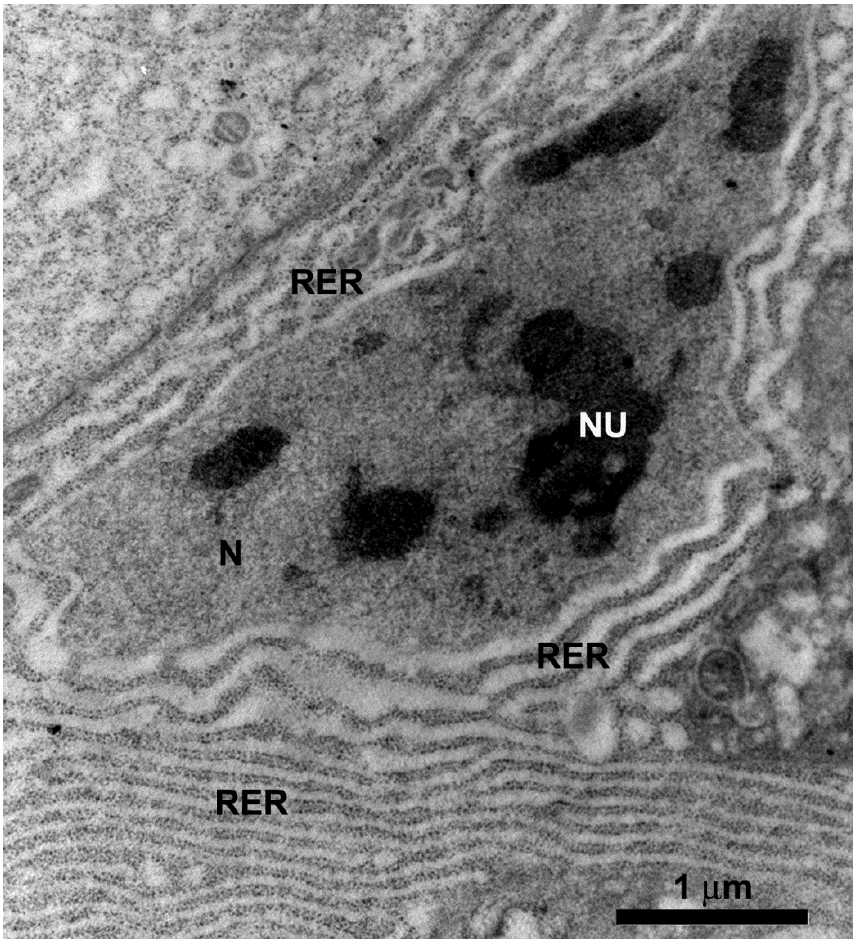
Figure 6. Transmission electron micrograph of the median region of the digestive cell in the midgut of Friesella schrottkyi worker showing well-developed nucleus (N) with decondensed chromatin and large nucleolus (Nu) and the perinuclear cytoplasm with rough endoplasmic reticulum (RER).